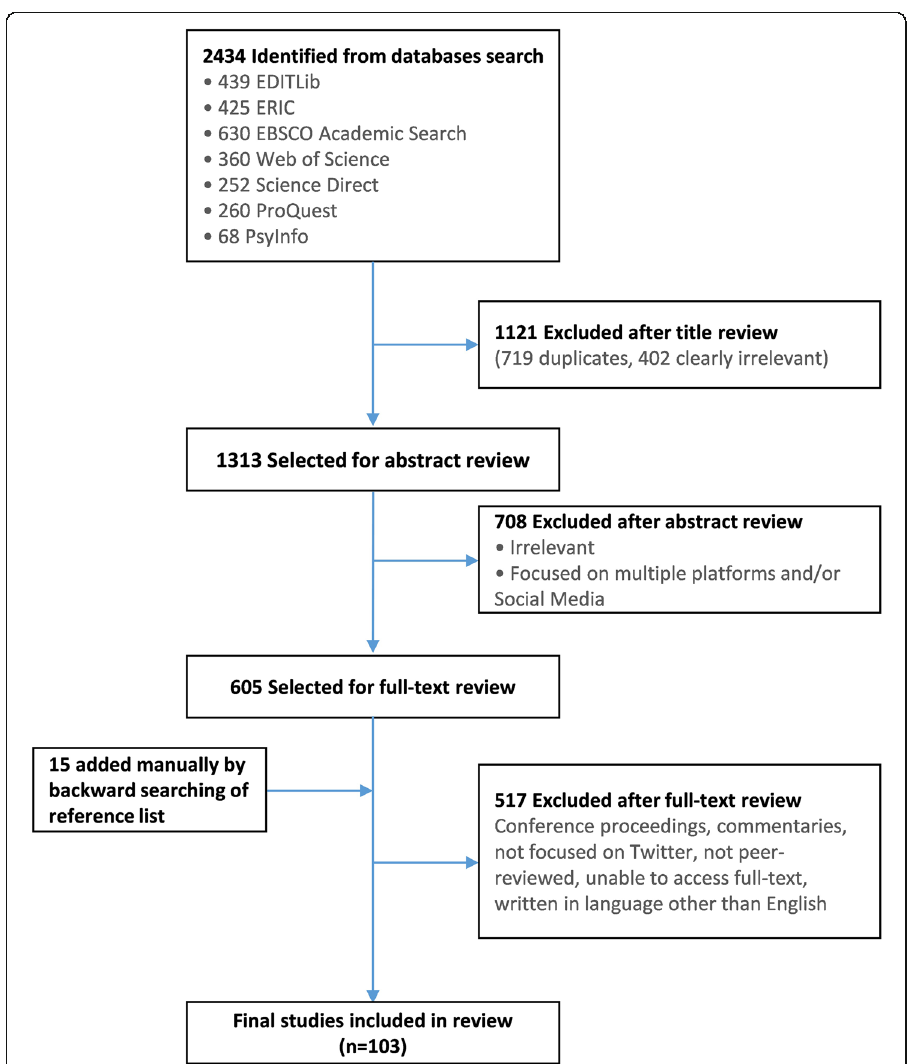
Fig. 1 PRISMA flow-chart for Twitter in